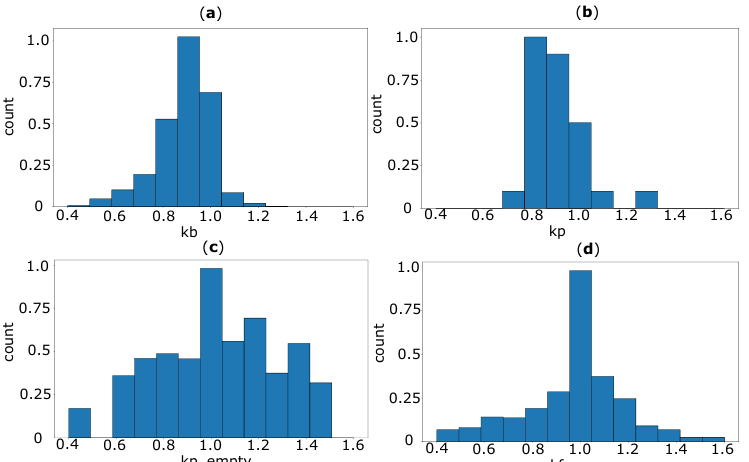
Figure 8. Strategy coefficient distributions: ( a ) coefficient of buying, ( b ) coefficient of setting price, ( c ) coefficient of setting price when market is empty, ( d ) coefficient of setting transaction fee.